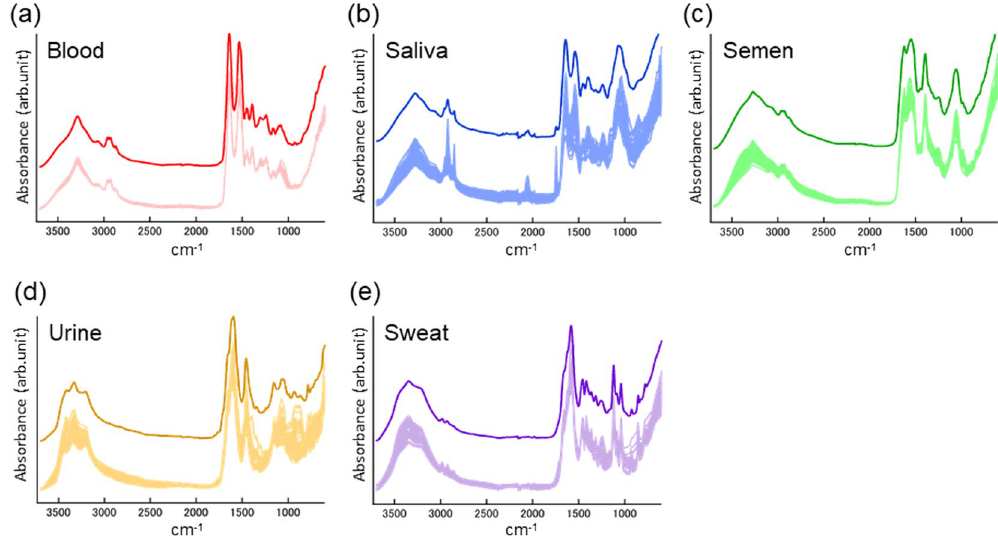
Figure 1. Characterization of the ATR FT-IR spectra of five types of BFs. Collected individual ATR FT-IR spectra (overlaid at the bottom) and the average spectra (top) from peripheral blood ( a ), saliva ( b ), semen ( c ), urine ( d ) and sweat ( e ) dried at ambient conditions overnight. Each spectrum was normalized by the total